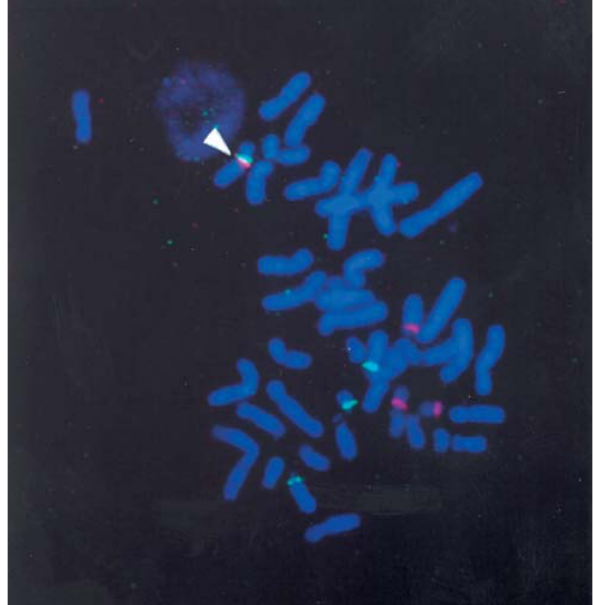
Figure 1 - FISH using 13/21 and 14/22 α -satellite probes (D14Z1/D22Z1 andD13Z1/D21Z1;Oncor)onametaphasefromthecontrolcultureforin- dividual 6612. The dicentric structure of the rob(14q21q) chromosome is seen at the arrow. Detection of the 13/21 and 14/22 α -satellite probes was performed using FITC (green) and Cy3 (red),